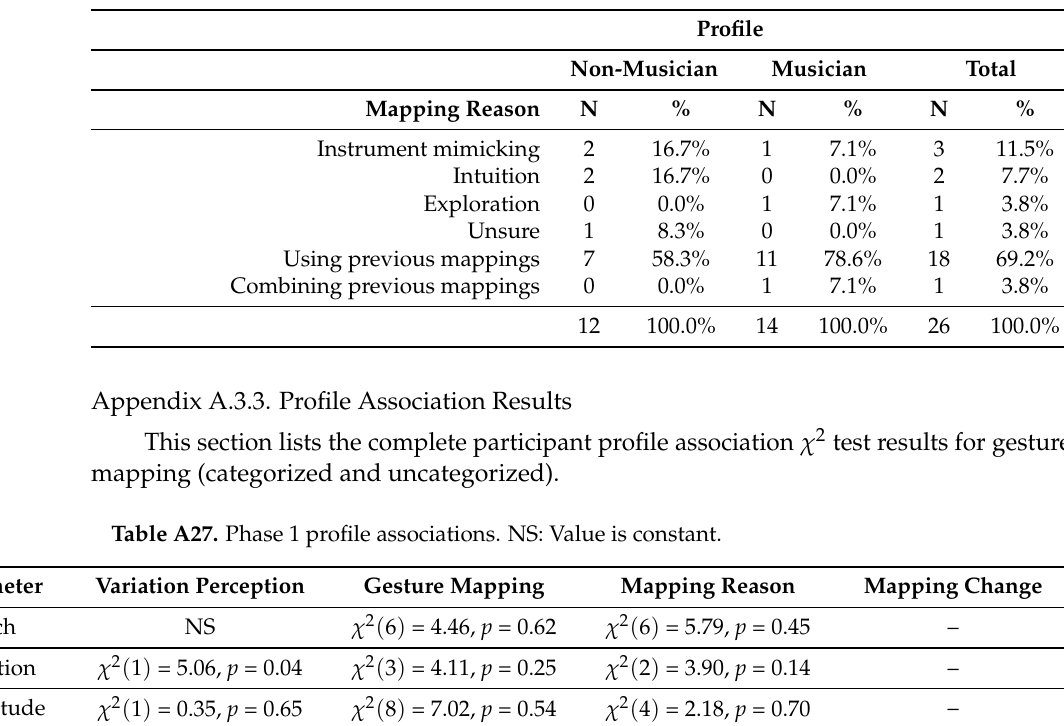
Table A26. Mapping rationale—stimulus e.